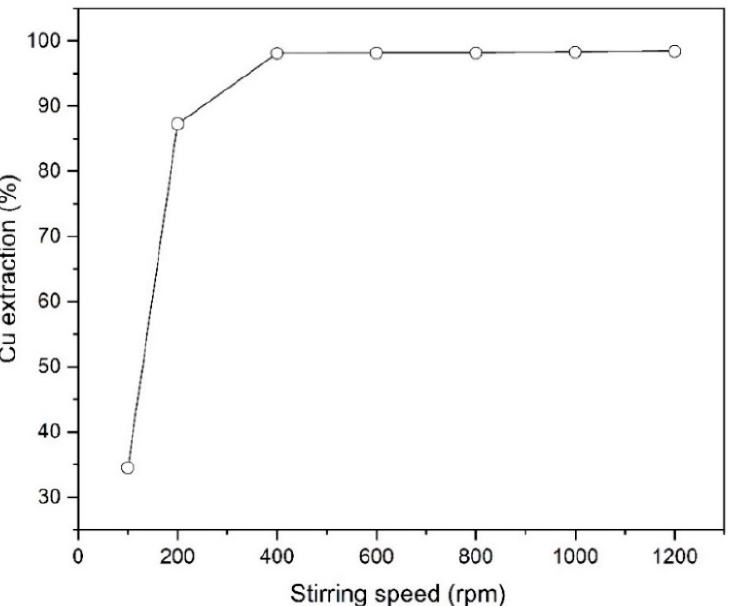
Figure 5. The effect of stirring speed on Cu extraction (Mextral 5640H = 10% ( v / v ), pH = 1.6, T = 25 ° C, t = 10 min and O/A = 1).